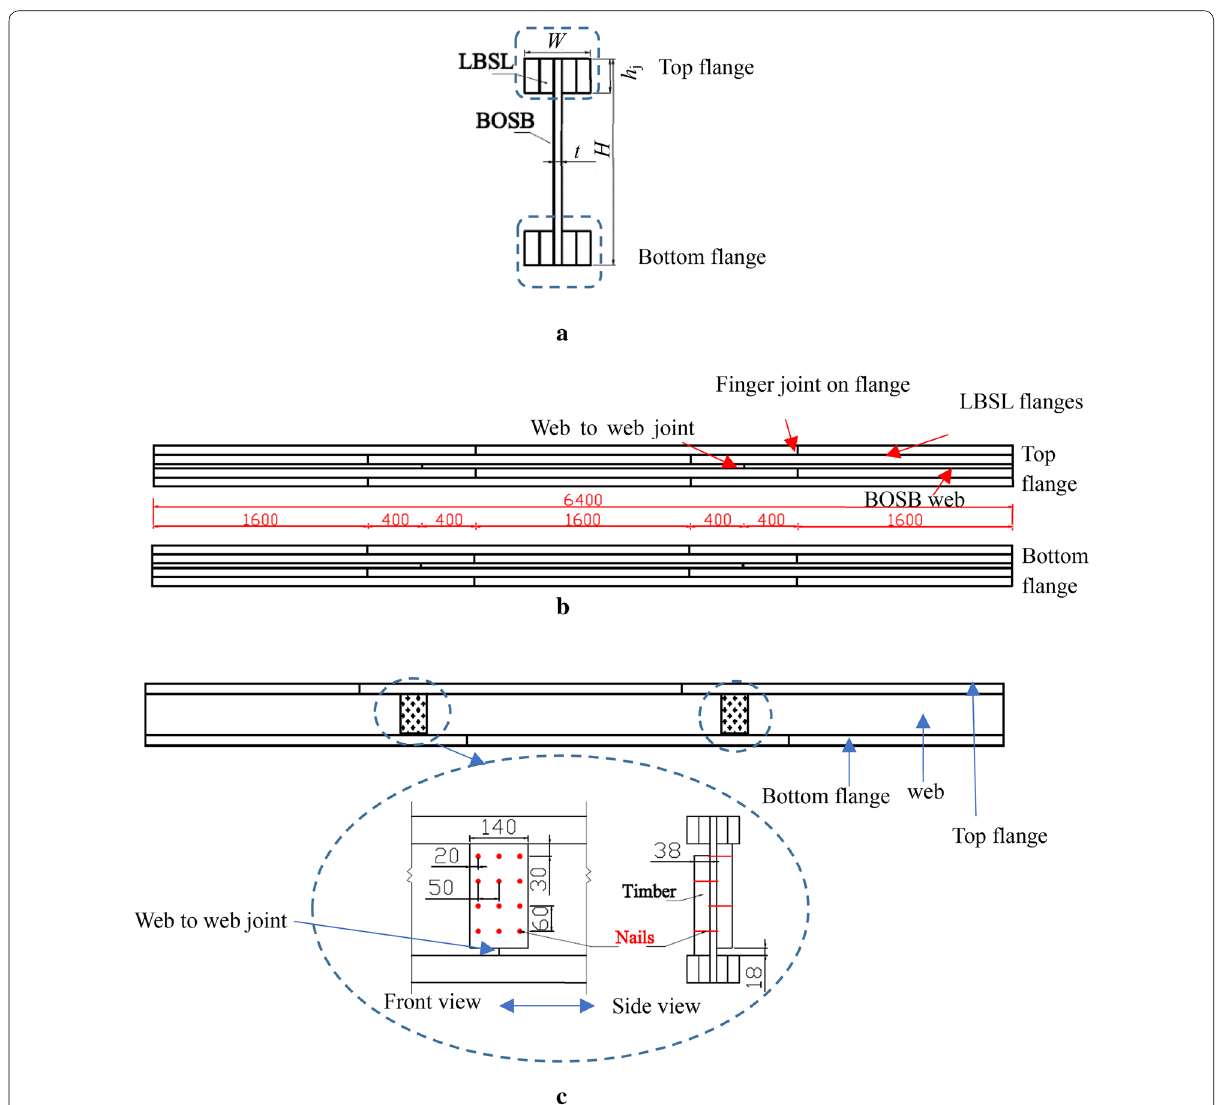
Fig. 2 Details of I-beam: a I-beam cross-section; b stagger-jointed assembling of flanges and web from top view of I-beam; c nail-glued timber on web-to-web joint (mm)